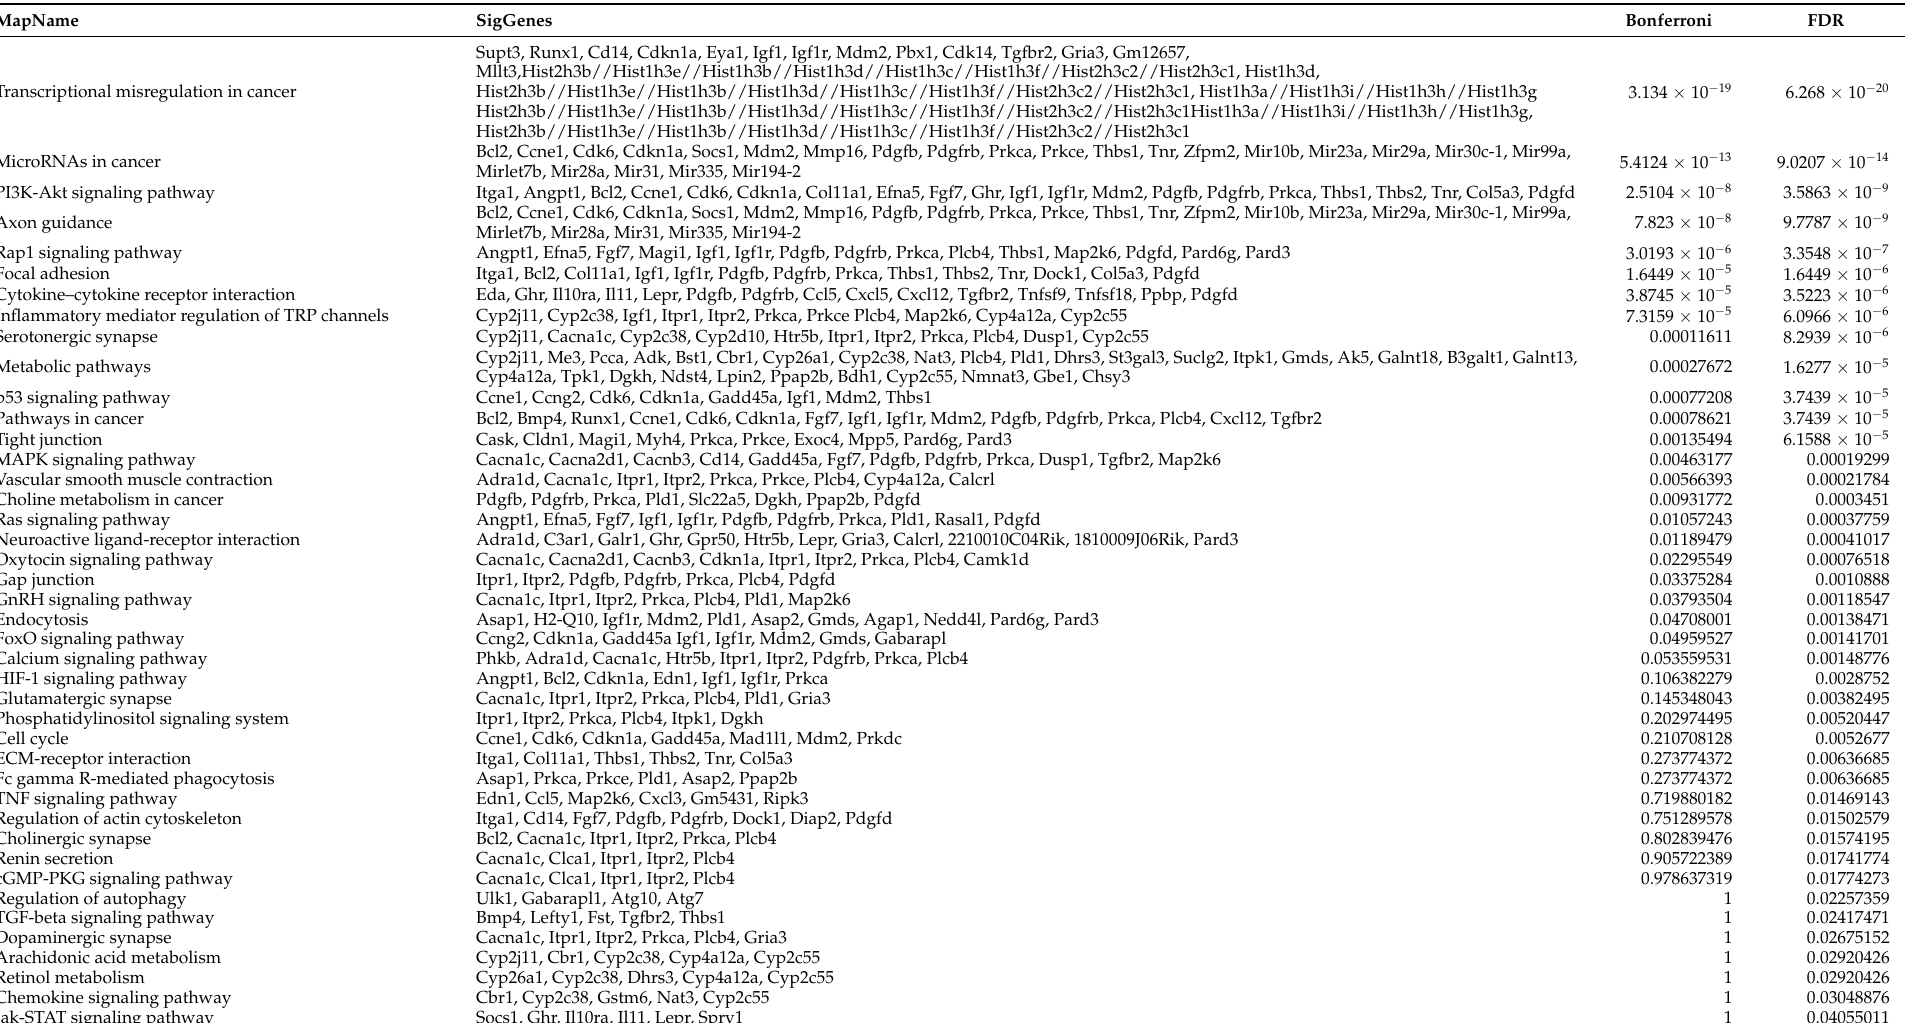
Table 1. Analysis of enrichment of KEGG pathways and involved genes in 24 h metformin-pretreated